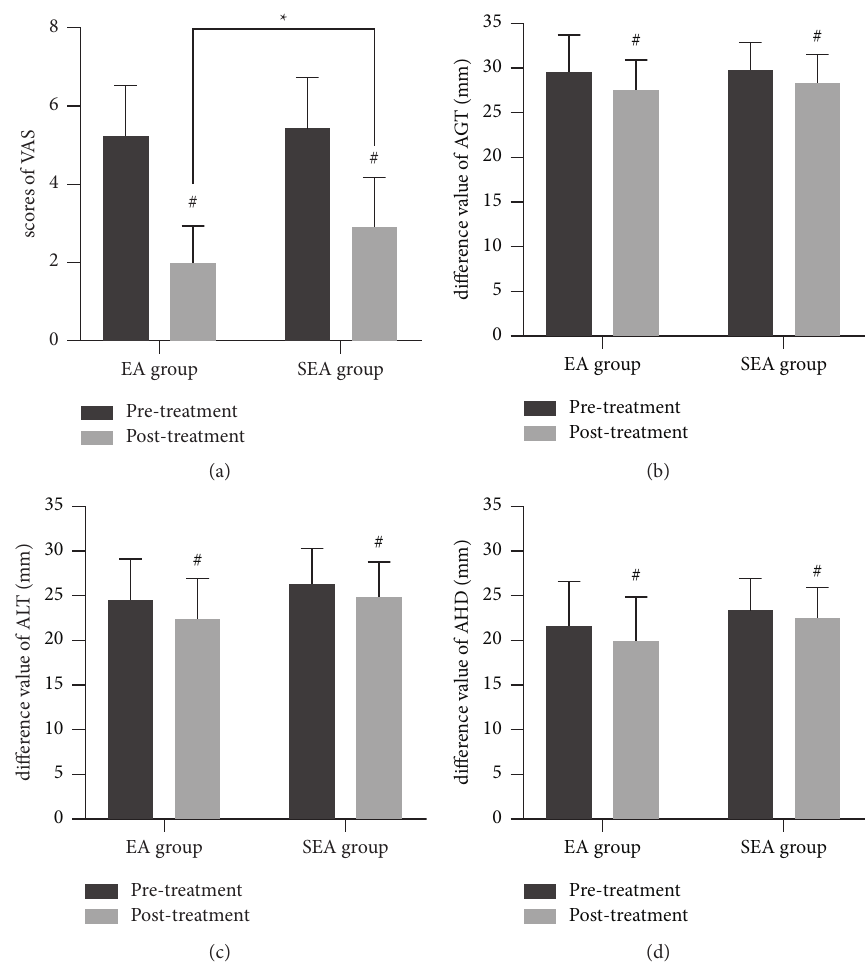
Figure 4: Comparison of VAS scores and measures of shoulder subluxation distances between the two groups before and after treatment. Comparison within groups: # p < 0 . 05. Comparison between groups: ∗ p < 0 .